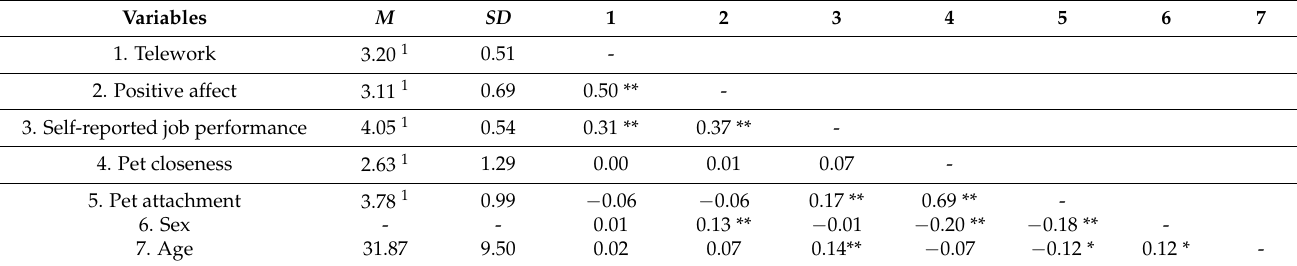
Table 1. Correlations and descriptive statistics of the variables under study.